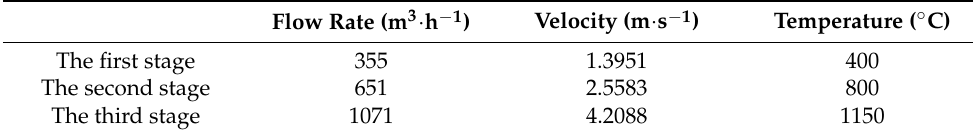
Table 4. The conditions of the burner